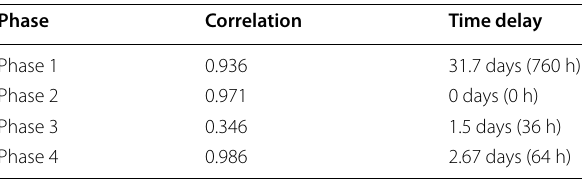
Table 1 Functional correlations and the time measured in days, where the correlation measure is maximum, for each phase